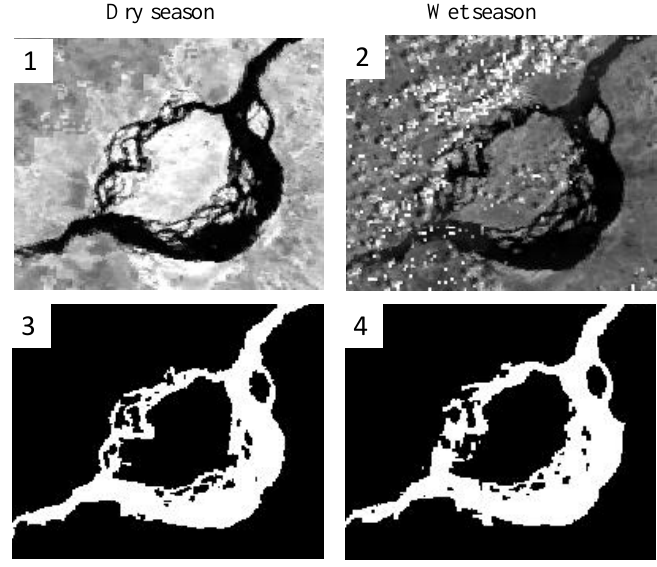
Figure 21. ( 1 , 2 ) are two examples of the river section (Congo River, Malebo Pool) in dry and wet seasons. ( 3 , 4 ) are the water mask determined by the proposed